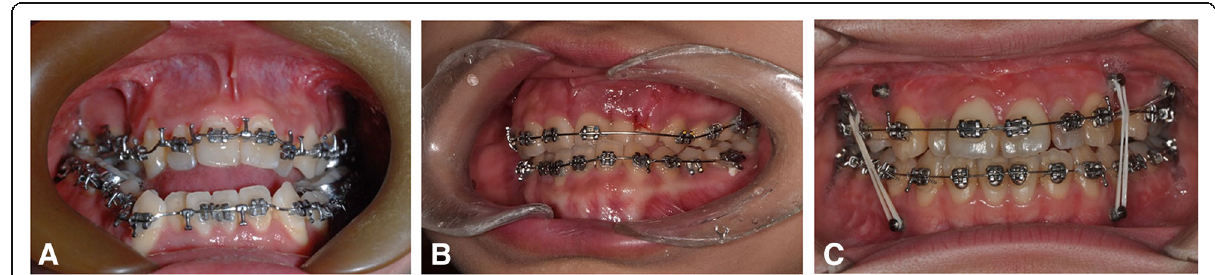
Fig. 6 a For the SFA, it is difficult to passively adapt the surgical rectangular wire to the irregular dentition. b To maintain passivity of the surgical archwire, not all the teeth are bracketed. c 016 × 016 light rectangular wire with MMF screws are commonly used for surgery-first